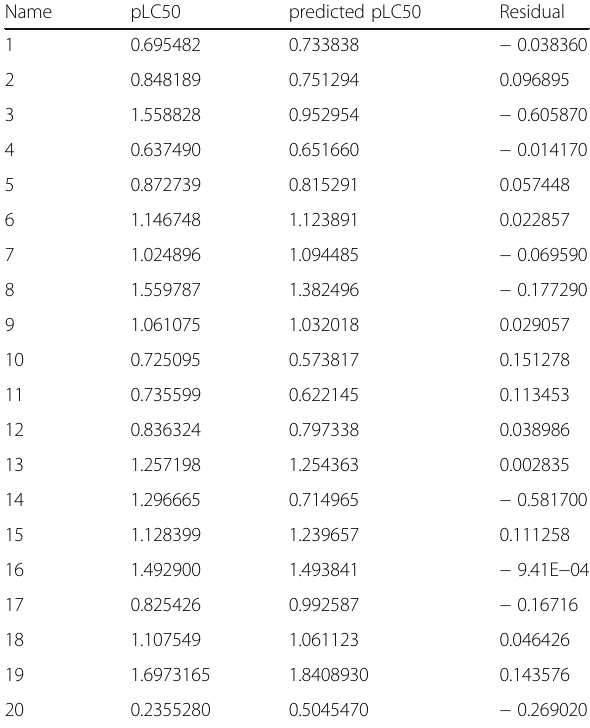
Table 6 The experimental, predictive, and residual